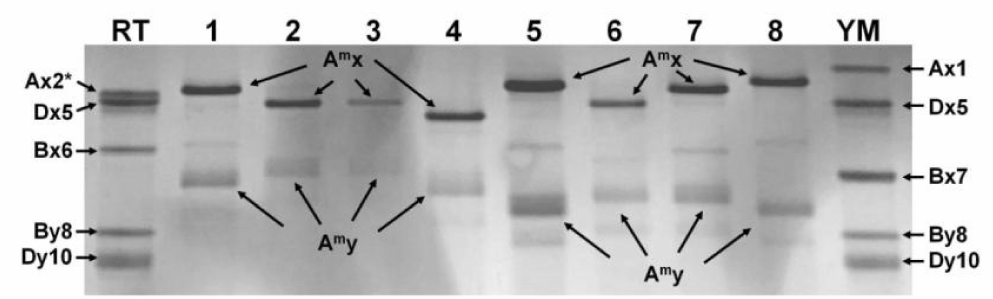
Figure 1. SDS-PAGE of representative variation for HMWGs found in the wild einkorn collection. Lanes are as follows: RT , common wheat cv. Rota; 1 , PI 554559; 2 , PI 427622; 3 , PI 427623; 4 , PI 554504; 5 , PI 554548; 6 , PI 427453; 7 , PI 554521; 8 , PI 470720; and YM , common wheat cv.